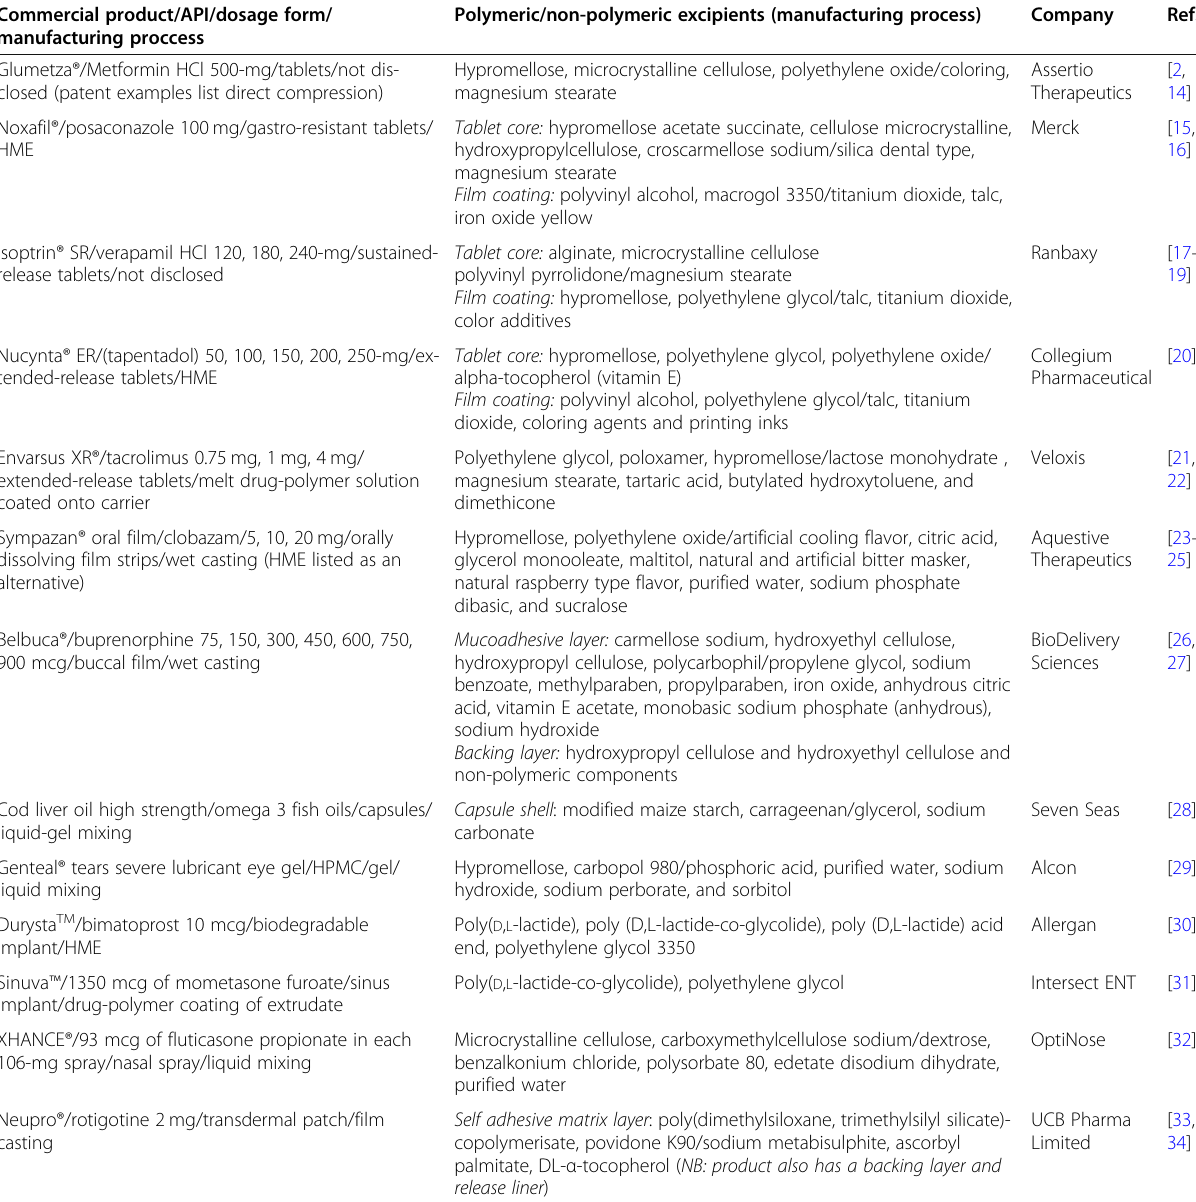
Table 5 Polymer blends in selected marketed products Commercial product/API/dosage form/ manufacturing